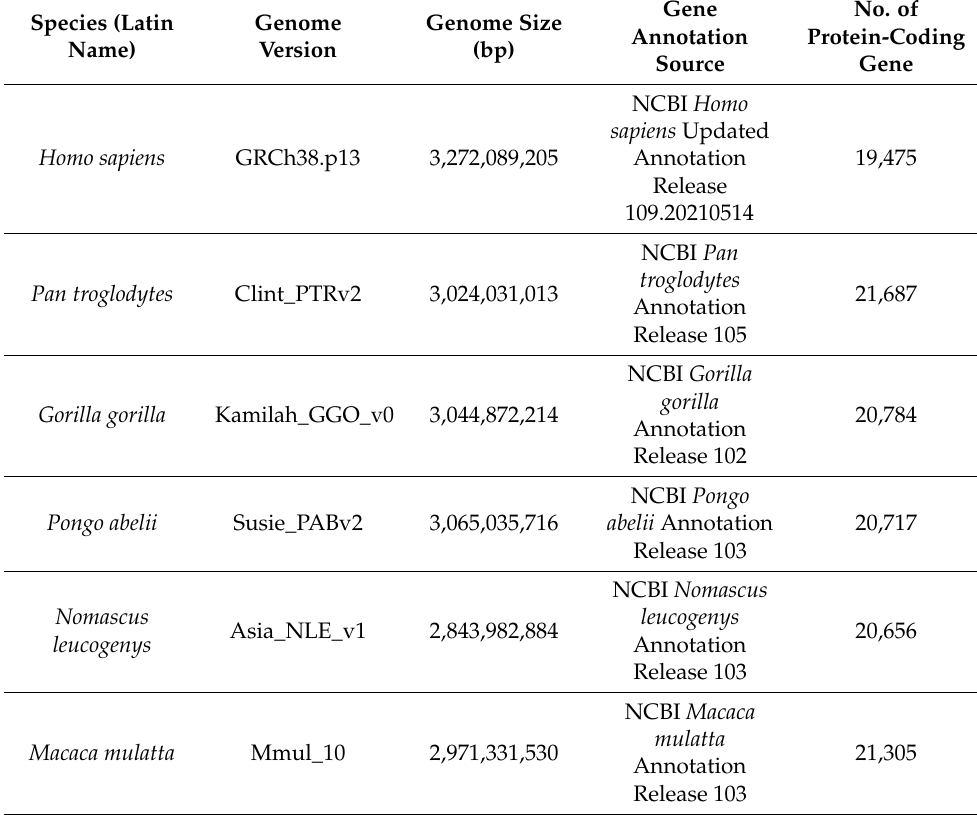
Table 1. Summary of assembly and annotation statistics for the primate